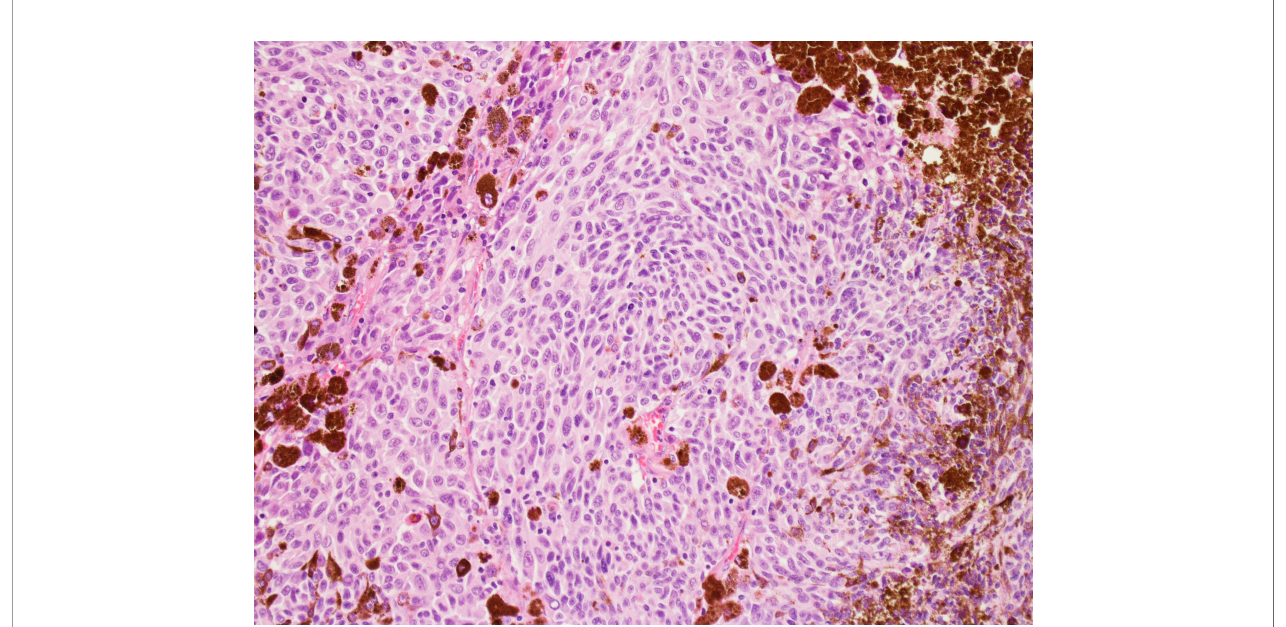
FIGURE 1 | Haematoxylin-eosin histopathological analysis of uveal melanoma. (With permission of Prof. Giovanni Lanza, Institute of Pathological Anatomy, University of